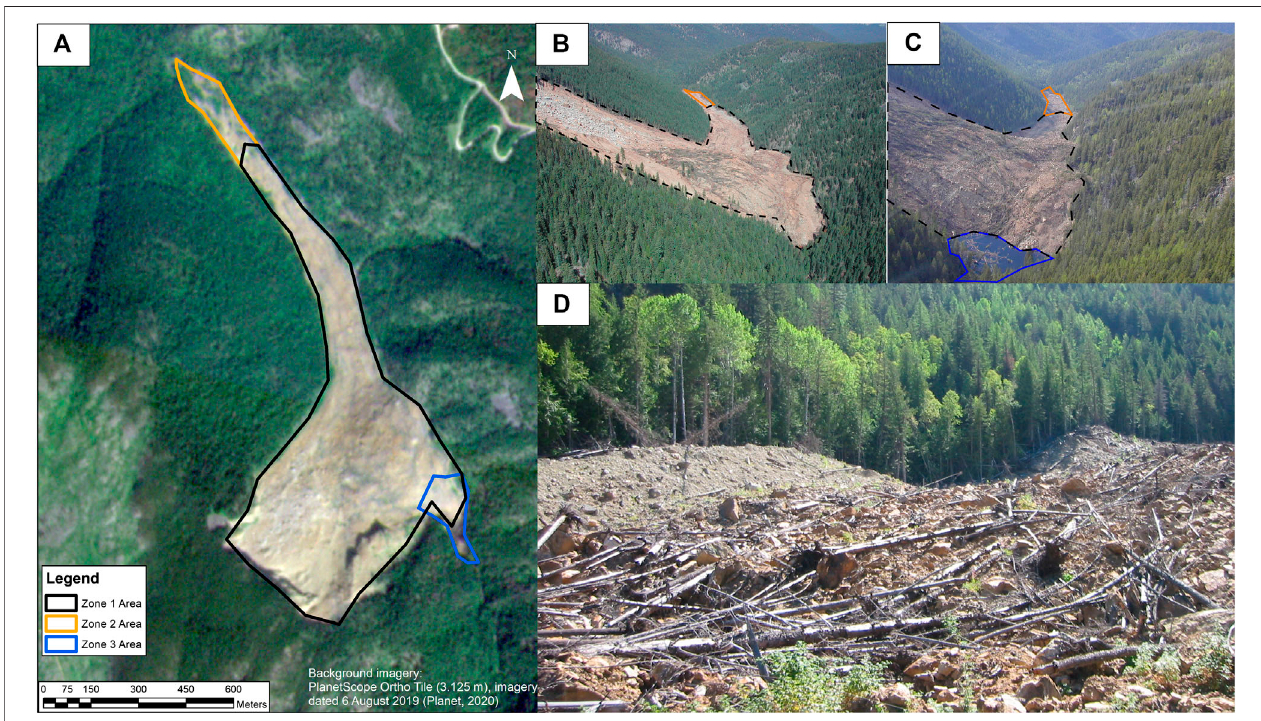
FIGURE 6 | McAuley Creek rock avalanche (A) impact area delineations on a satellite image from August 6, 2019 (Planet, 2020), (B) oblique view of the main deposition area with the tongue of more mobile material extending into the background from August 21, 2002 (photo courtesy Réjean Couture), (C) oblique view of the deposit area showing the transient landslide dammed lake from June 10, 2002 (photo courtesy Scott Paddington), and (D) a photo of the north margin of the deposit near the transition from what was mapped as Zone 1 and Zone 2.